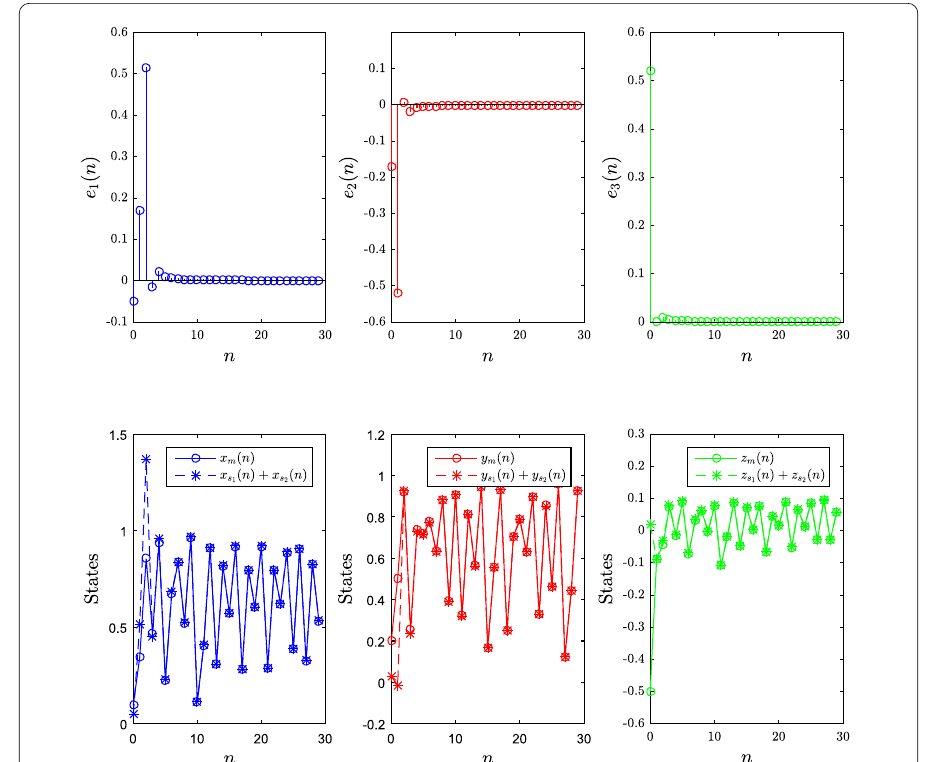
Figure 22 Time evolution of the synchronization errors for the proposed combined synchronization